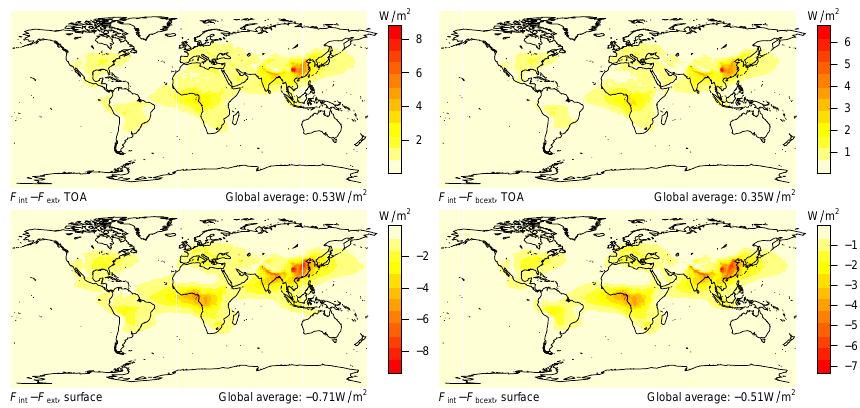
Figure 12. Difference in net shortwave flux between internal and external mixing F int − F ext (top left) and between internal and intermediate mixing state F int − F bcext (top right) at the top of the atmosphere, averaged over the year 2005. The bottom row shows the corresponding values at the